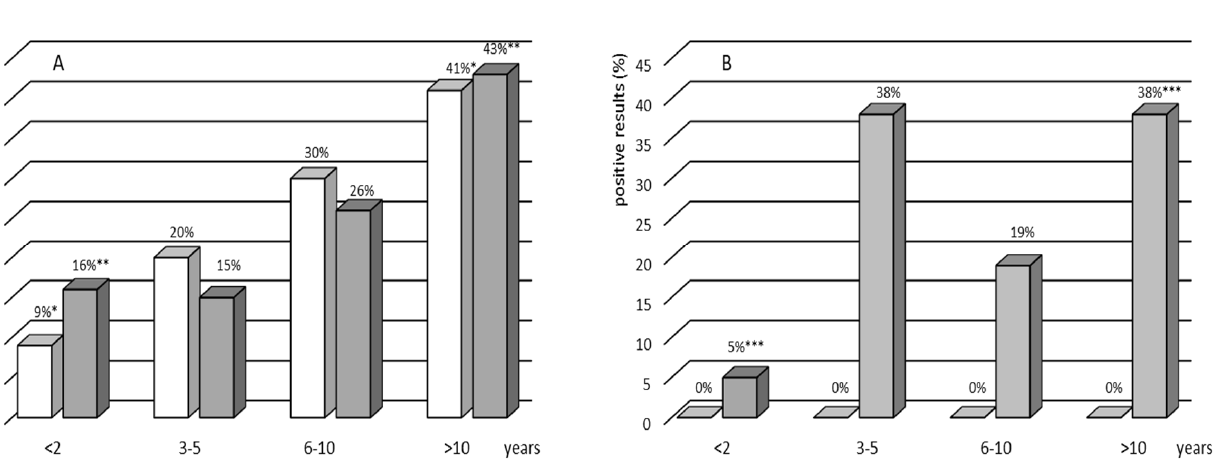
Table 2. Comparison of the tuberculin skin test (TST) and interferon-gamma release assay (IGRA) results among TB contact and no TB contact volunteers.